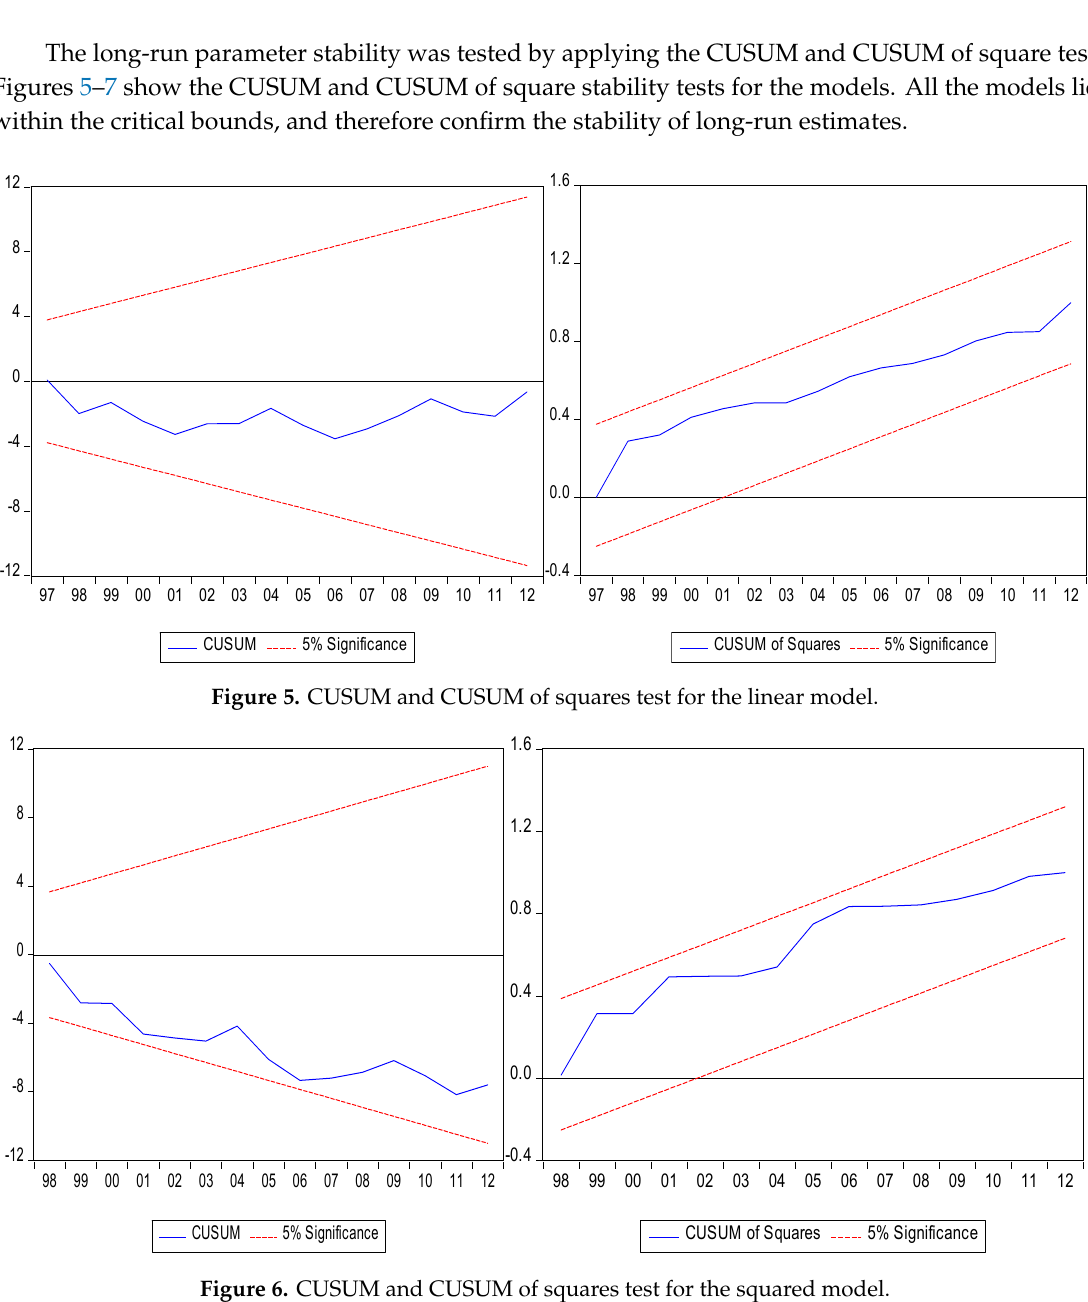
Table 9. Residual diagnostic tests.